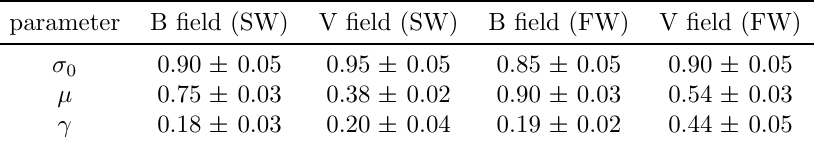
Table 5: The values of the parameters 𝜎 0 , 𝜇 , and 𝛾 , in the fit of 𝜆 2 ( 𝜏 ) (see Equation (69) as a kernel for the scaling behavior of PDFs. FW and SW refer to fast and slow wind, respectively, as obtained from the Helios 2 spacecraft, by collecting in a single dataset all periods.